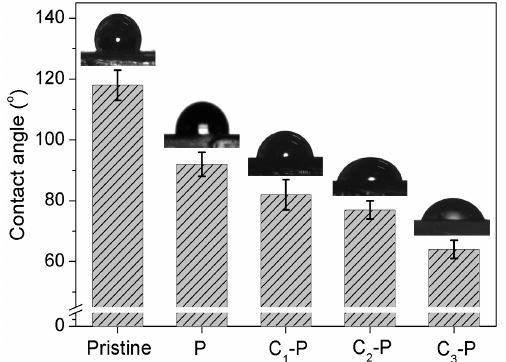
Figure 6. Contact angle test results for different sample.